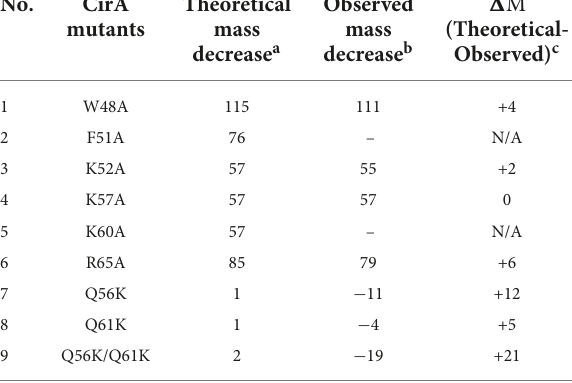
TABLE 3 Matrix-assisted laser desorption/ionization-time of flight (MALDI-TOF) mass detection to confirm the production of circularin A variants.